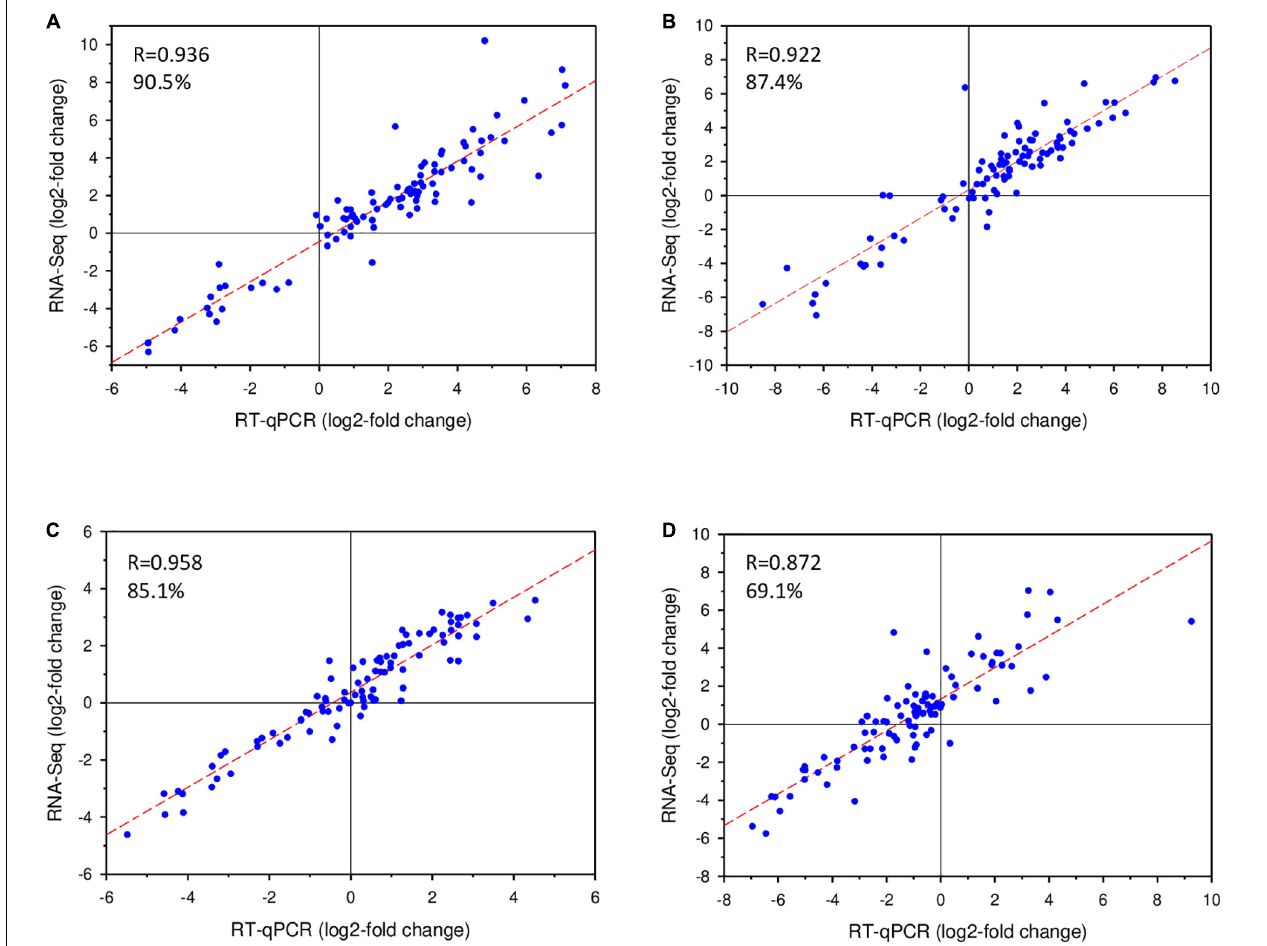
FIGURE 3 | Validation of RNA-Seq data by RT-qPCR. Log2-values of fold-changes of gene expression at pH 4.5 and pH 7.0 detected by RNA-Seq were plotted against RT-qPCR data. Rates of validation are indicated as percentages in the graphs. (A) B. microti , 20 min; (B) B. microti , 120 min; (C) B. suis , 20 min; (D) B. suis , 120